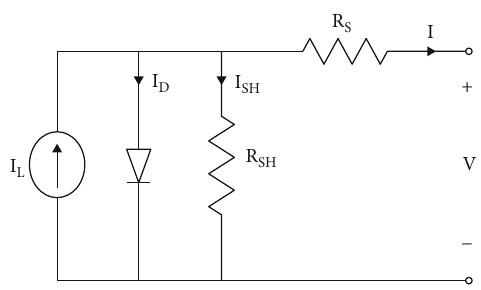
Figure 17: SPV cell equivalent circuit